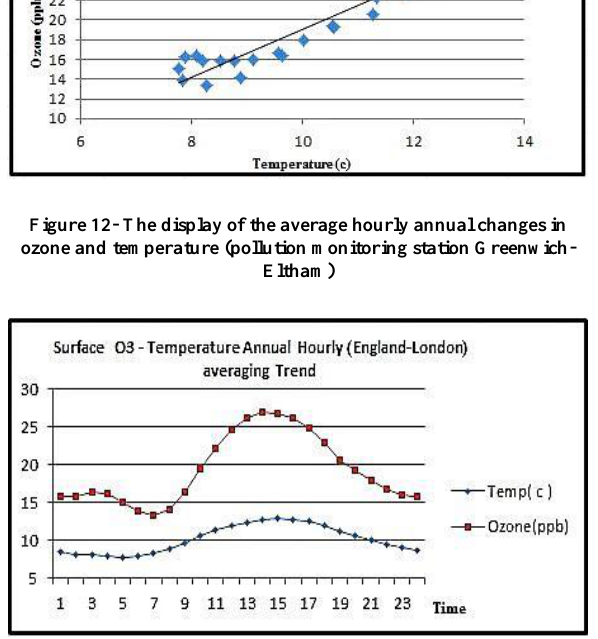
Figure 13- The correlation between ozone and hourly temperature (pollution monitoring station Greenwich-Eltham)